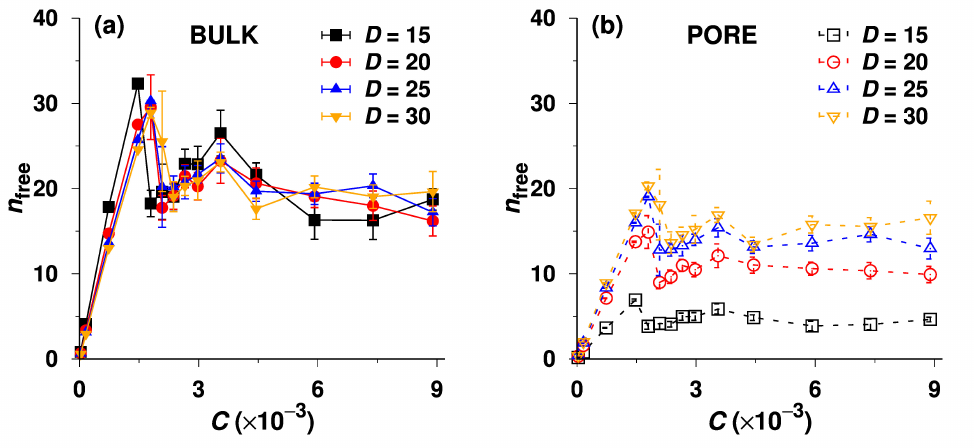
Figure 3. ( a ) Number of free chains, n free , in the bulk phase as a function of the total concentration, C , for various pore diameters, D . ( b ) Number of free chains, n free , in the pore as a function of C , for various D